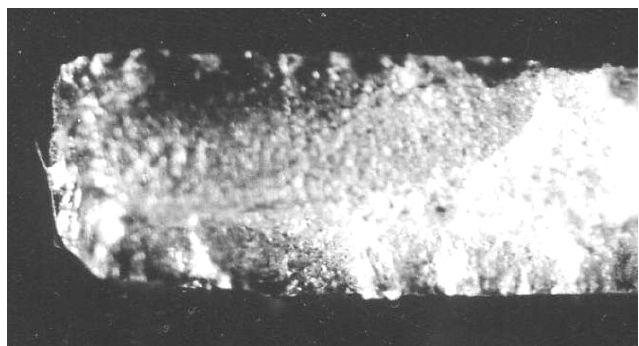
Figure 2. Surface of crack in an undercarriage bay bracket.